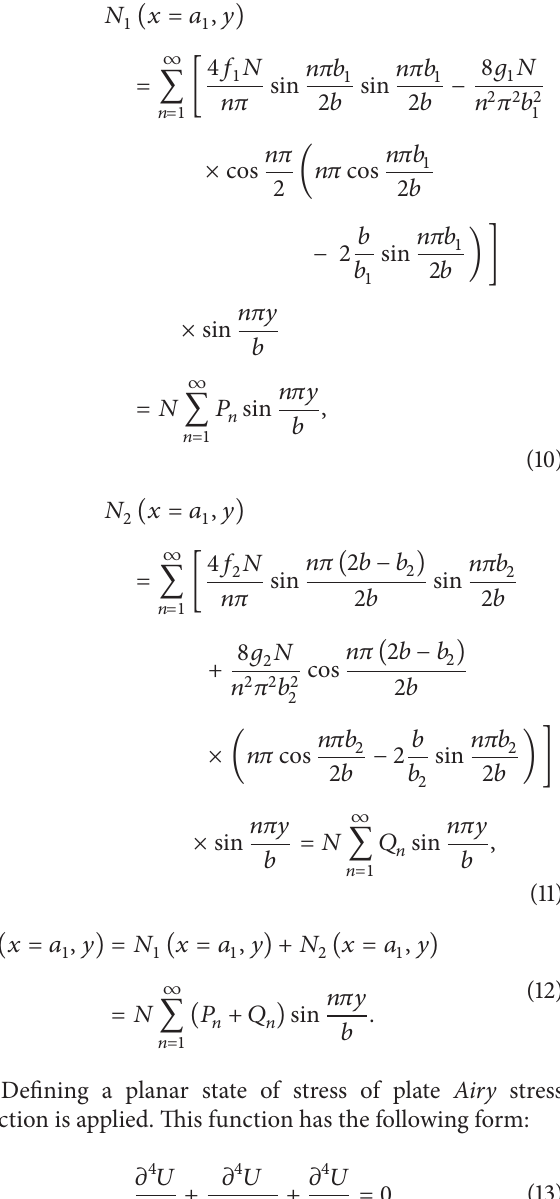
Model of planar state of plate with rectangular